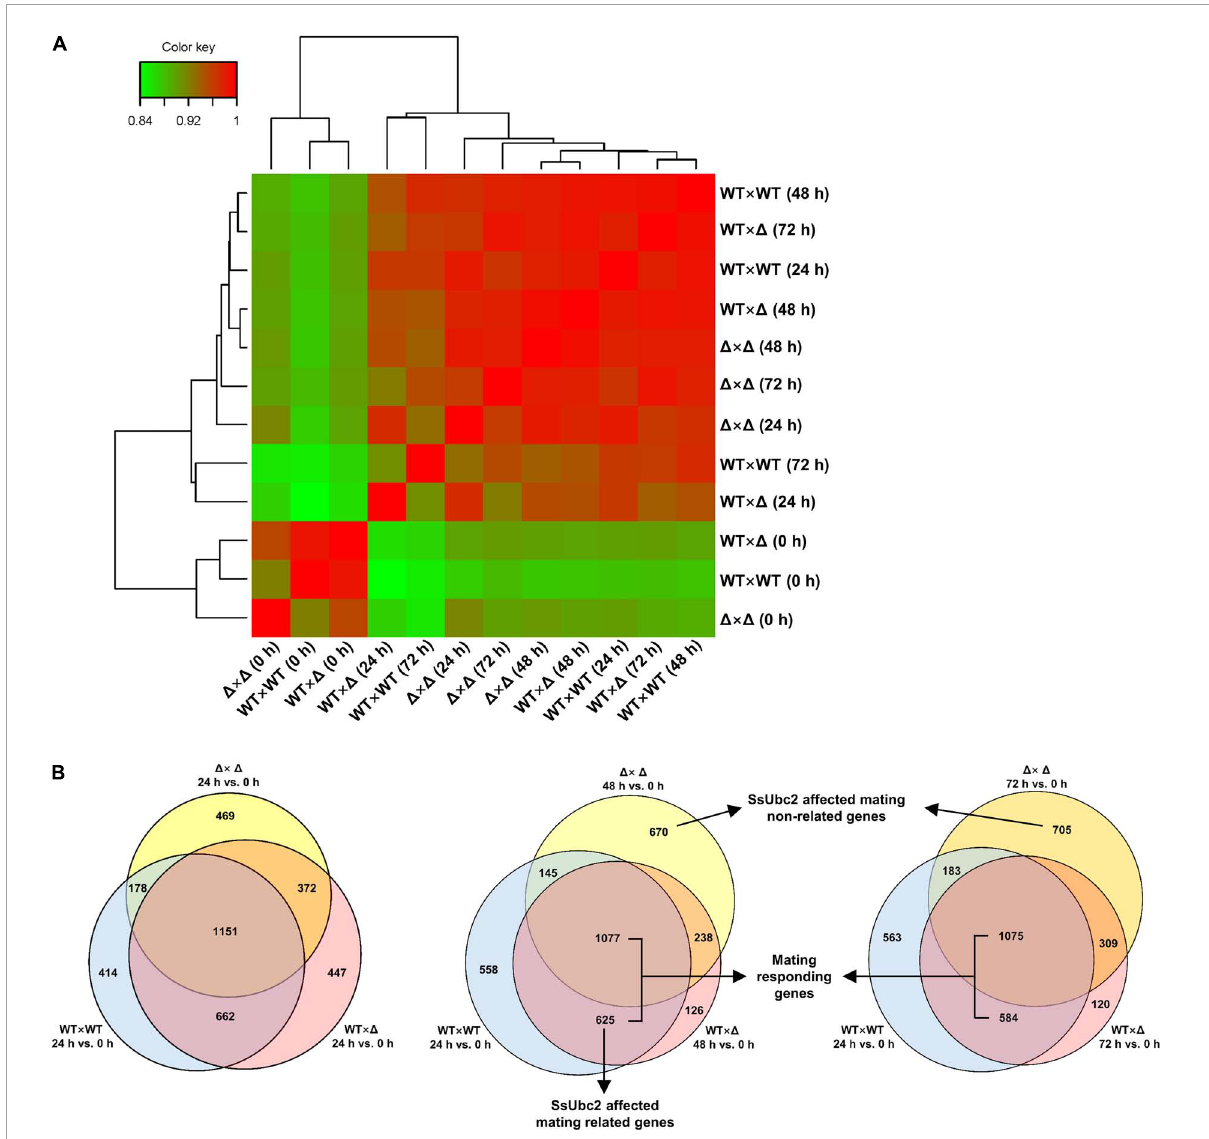
FIGURE7 Comparison of transcriptional reprogramming during sexual mating among pairing strains. (A) Hierarchical cluster diagram of transcriptomes. The color scale from green to red represents lower to higher sample correlations based on gene expression. Branch lines generated by the same node indicate that the corresponding samples can be grouped into one cluster, and the length of the branch represents the similarity of the samples: the shorter the branch, the greater the similarity between samples. (B) Comparison of reprogrammed genes (DEGs) at different time points. DEGs were defined by reference to time 0 for each of the samples,